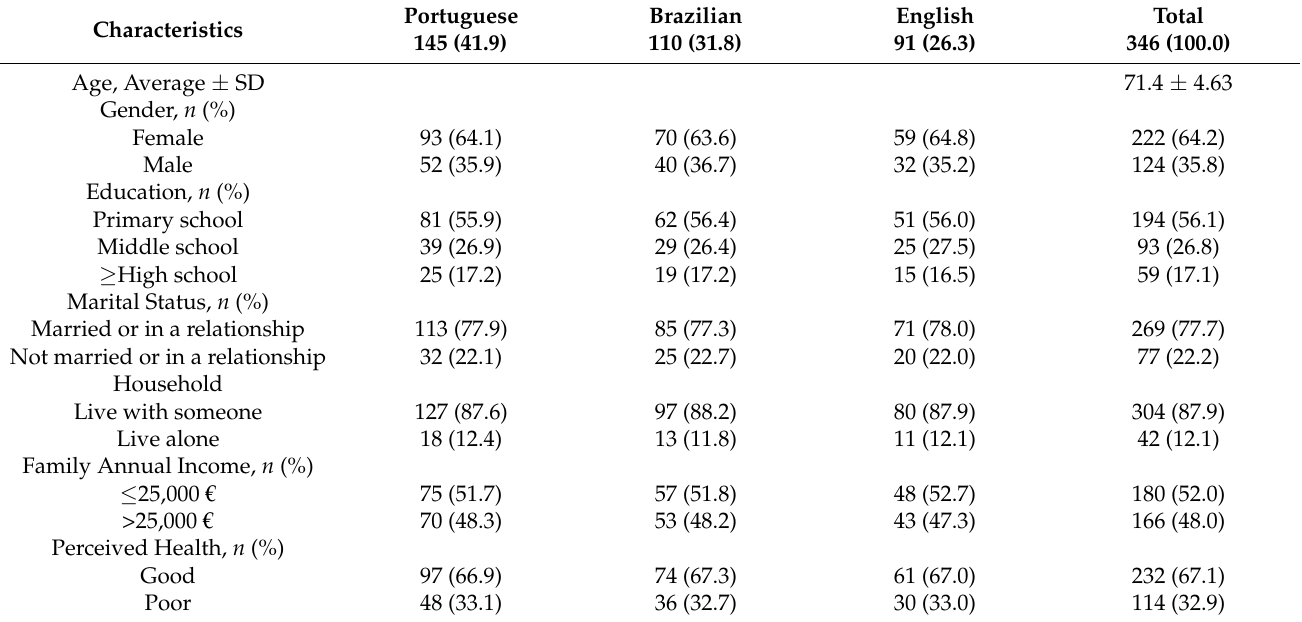
Table 1. Sample of sociodemographic and health